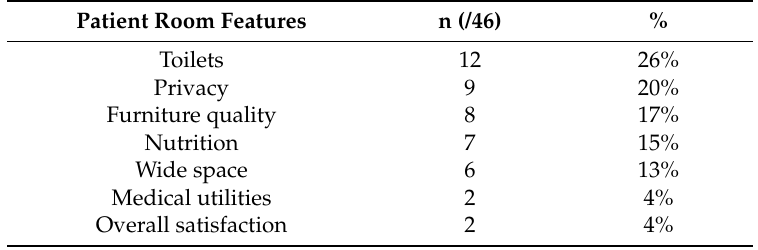
Table 7. Number and percentage of indicators grouped according to Patient room topics.